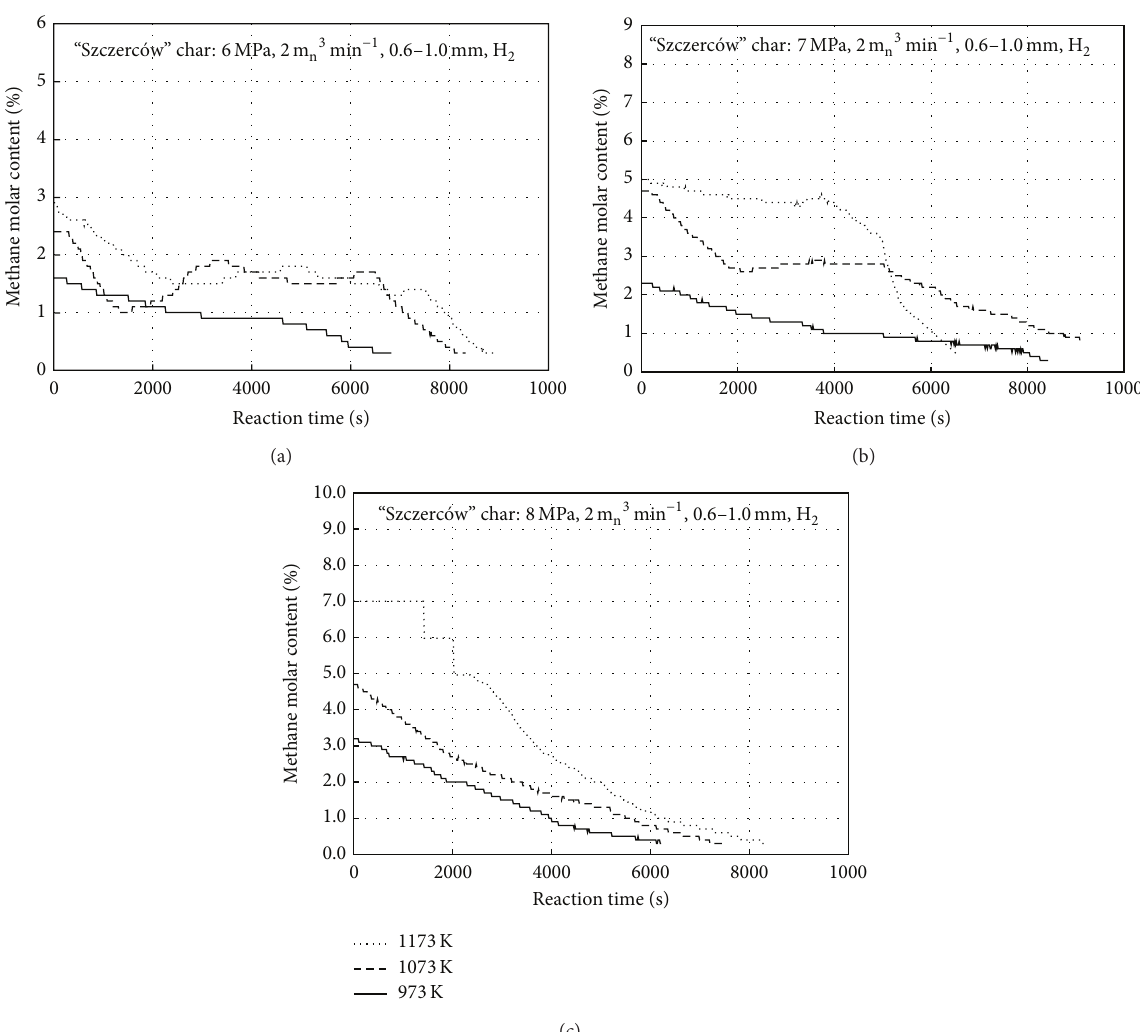
Figure 4: Measured molar content of the outflow gas methane versus time for “Szczerc´ow” char at 1173, 1073, and 973 K for (a) 6 MPa, (b) 7 MPa, and (c)